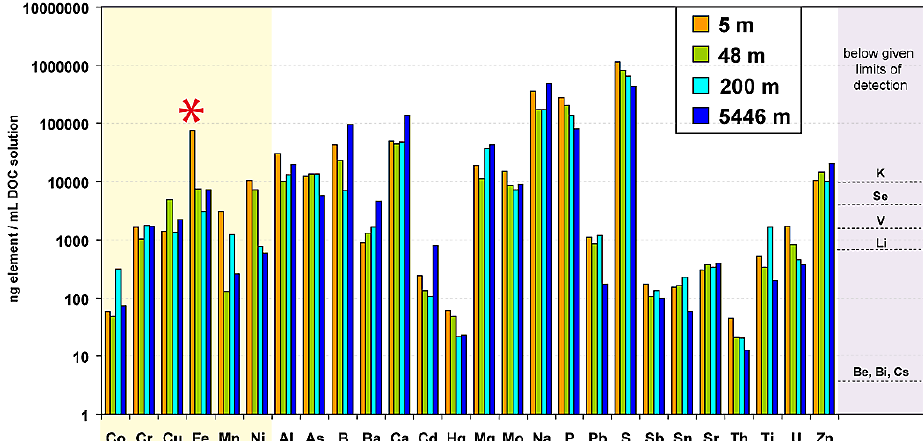
Fig. 20. Content of metals/elements in methanolic SPE-DOM solutions to assess metal contribution to NMR relaxation (note logarithmic display of concentration), yellow: significant metals capable of forming paramagnetic coordination compounds with marine SPE-DOM, with iron (Fe) in surface SPE-DOM at 5m as the most abundant (asterisk; cf. text); purple background: elements Be, Bi, Cs, K, Li, Se and V were found below detection limits indicated (cf. Table